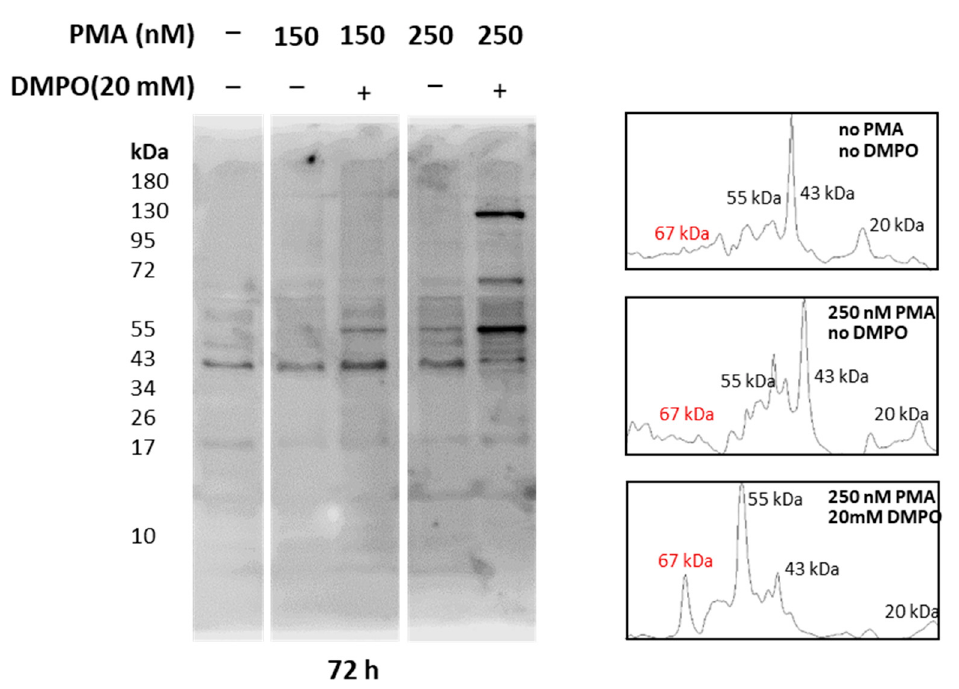
Figure 8. Identification of protein-DMPO nitrone adducts in U-937 cells differentiated with PMA. Western blot analysis of protein-DMPO nitrone adducts in whole-cell homogenates treated with 150 nM and 250 nM PMA for 72 h ( left panel ) and their corresponding densitograms ( right panel ).